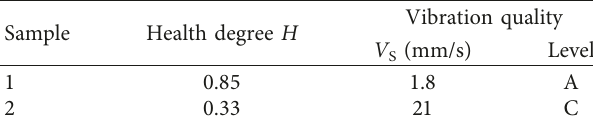
Table 3: Measured health and vibration quality of diesel engine.